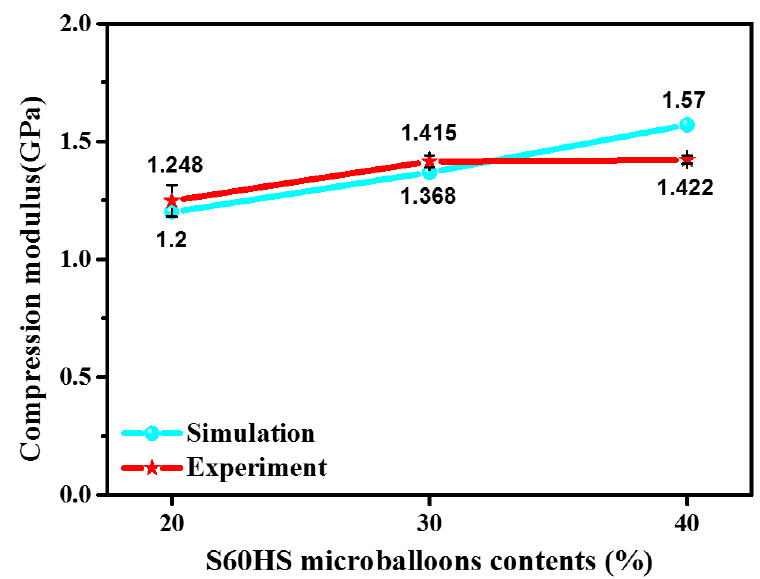
Figure 7. The simulation and experimental results of compression modulus for specimens with different S60HS microballoons contents.